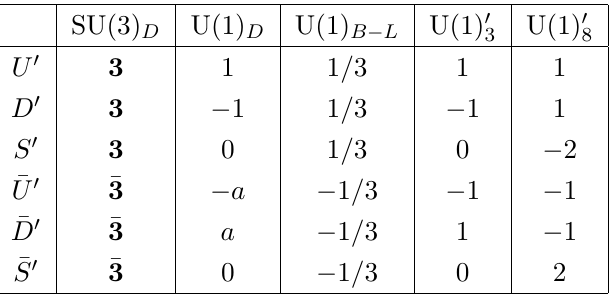
and U(1) 0 symmetries 3 8 V